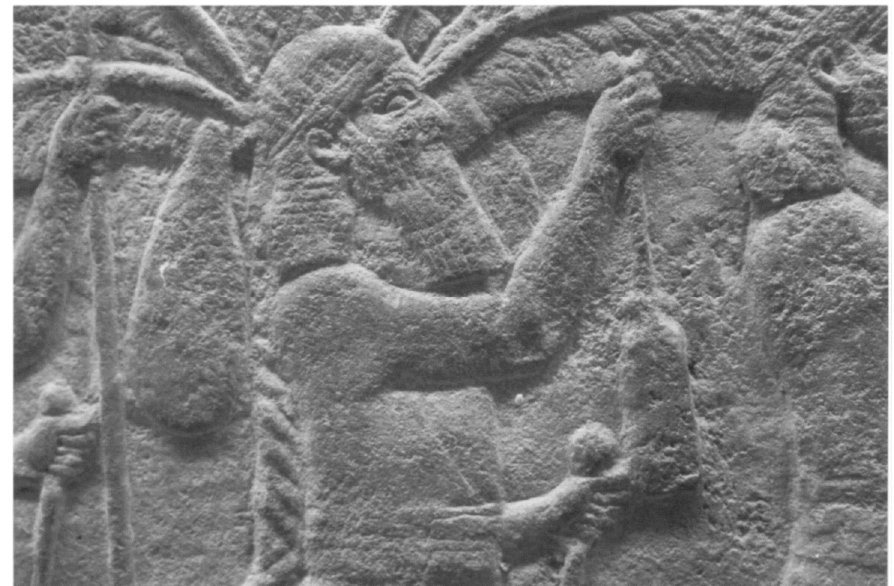
Figure 14. The royal seal of the Babylonian king Šamaš-šumu-uk ī n as identified by Novotny and Watanabe 2008 (photograph by Watanabe, published in Novotny and Watanabe 2008, p. 116).